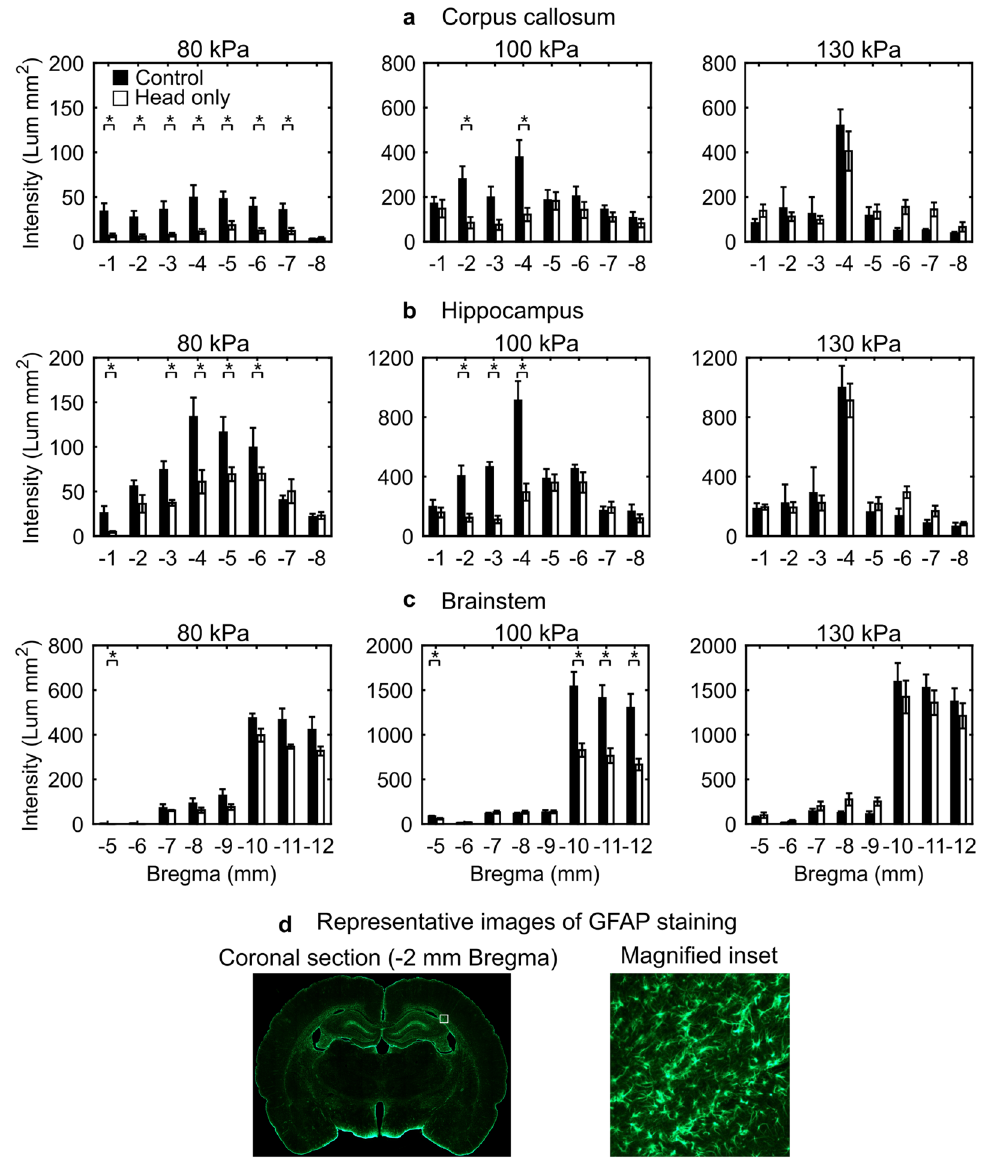
Figure 3. GFAP-positive staining in the ( a ) corpus callosum, ( b ) hippocampus, and ( c ) brainstem resulting from a single head-only blast-wave exposure in rats for incident blast overpressures (BOPs) of 80, 100, and 130 kPa in a shock tube. We conducted immunohistochemical analyses (i.e., GFAP staining) on coronal brain sections serially cut from − 1 to − 12 mm relative to Bregma and harvested them at 24 h post-exposure. To identify changes in GFAP-positive staining between control and head-only-exposed rats, we compared the data for a given brain region across each coronal section using the Mann–Whitney test. Asterisks denote statistically significant differences ( p < 0.05) between control (n = 5 for 80 and 100 kPa, and n = 4 for 130 kPa BOP) and blast- exposed groups (n = 5 for 80 kPa, and n = 10 for 100 and 130 kPa BOP). The bar height and vertical line length represent the mean and one standard error of the mean, respectively. The corpus callosum and hippocampus spanned from − 1 to − 8 mm relative to Bregma, while the brainstem spanned from − 5 to − 12 mm relative to Bregma. For the 80-kPa plots, we reduced the y-axis scale for each brain region to better illustrate the data. ( d ) Representative images of GFAP staining in a coronal brain section located at − 2 mm relative to Bregma. The magnified inset shows positively stained cells in the coronal section. GFAP glial fibrillary acidic